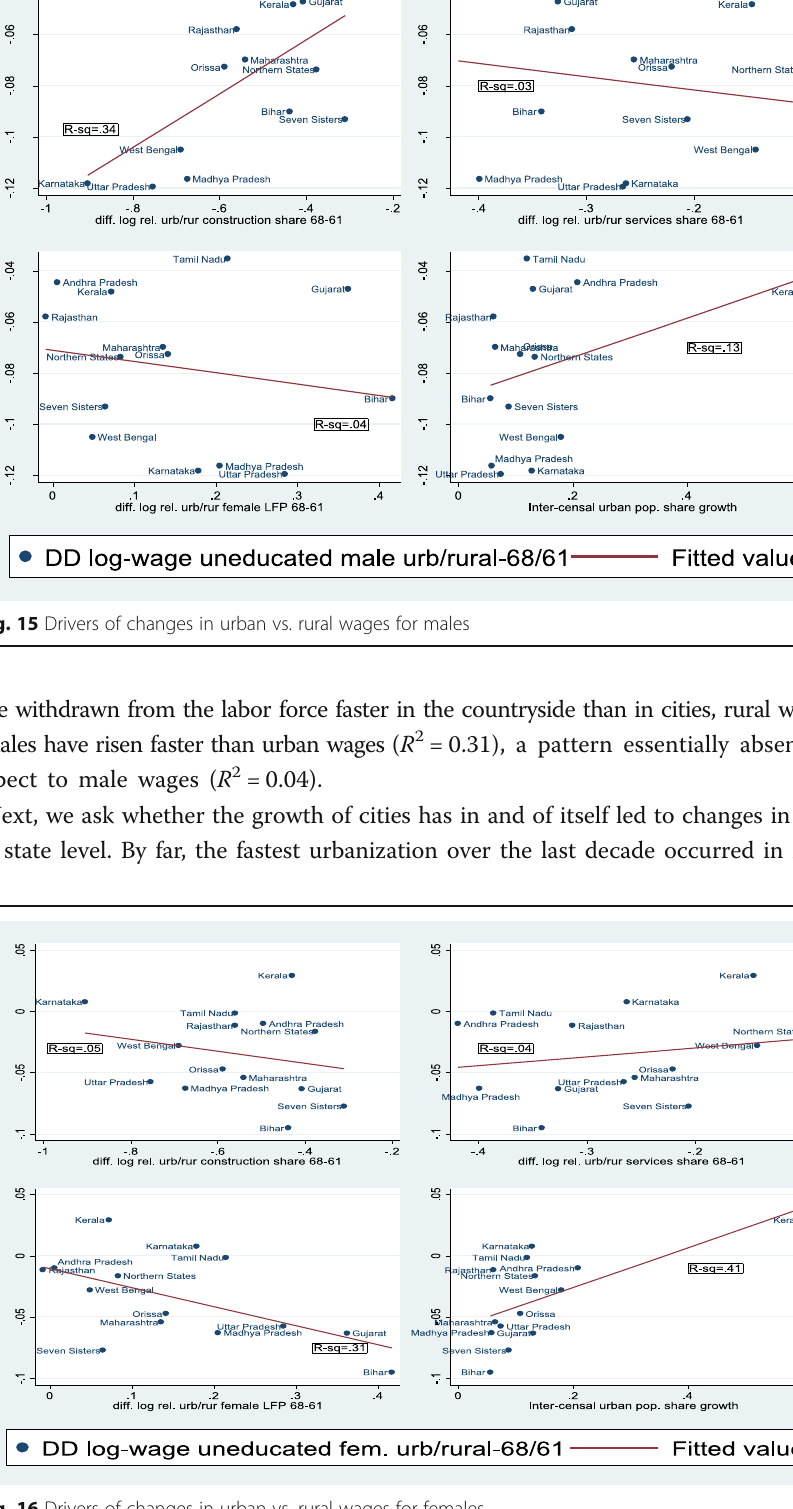
Fig. 16 Drivers of changes in urban vs. rural wages for